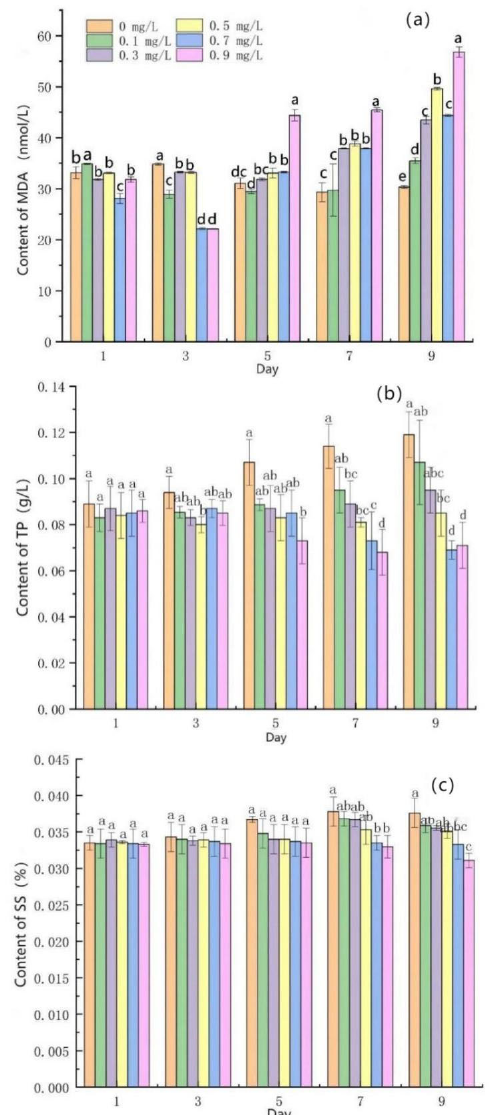
Figure 5. Effects of mercuric chloride concentration on the membrane permeability of Scenedesmus quadricauda : ( a ) content of MDA; ( b ) content of TP; ( c ) content of SS (N = 3, the calculated value is the standard deviation).